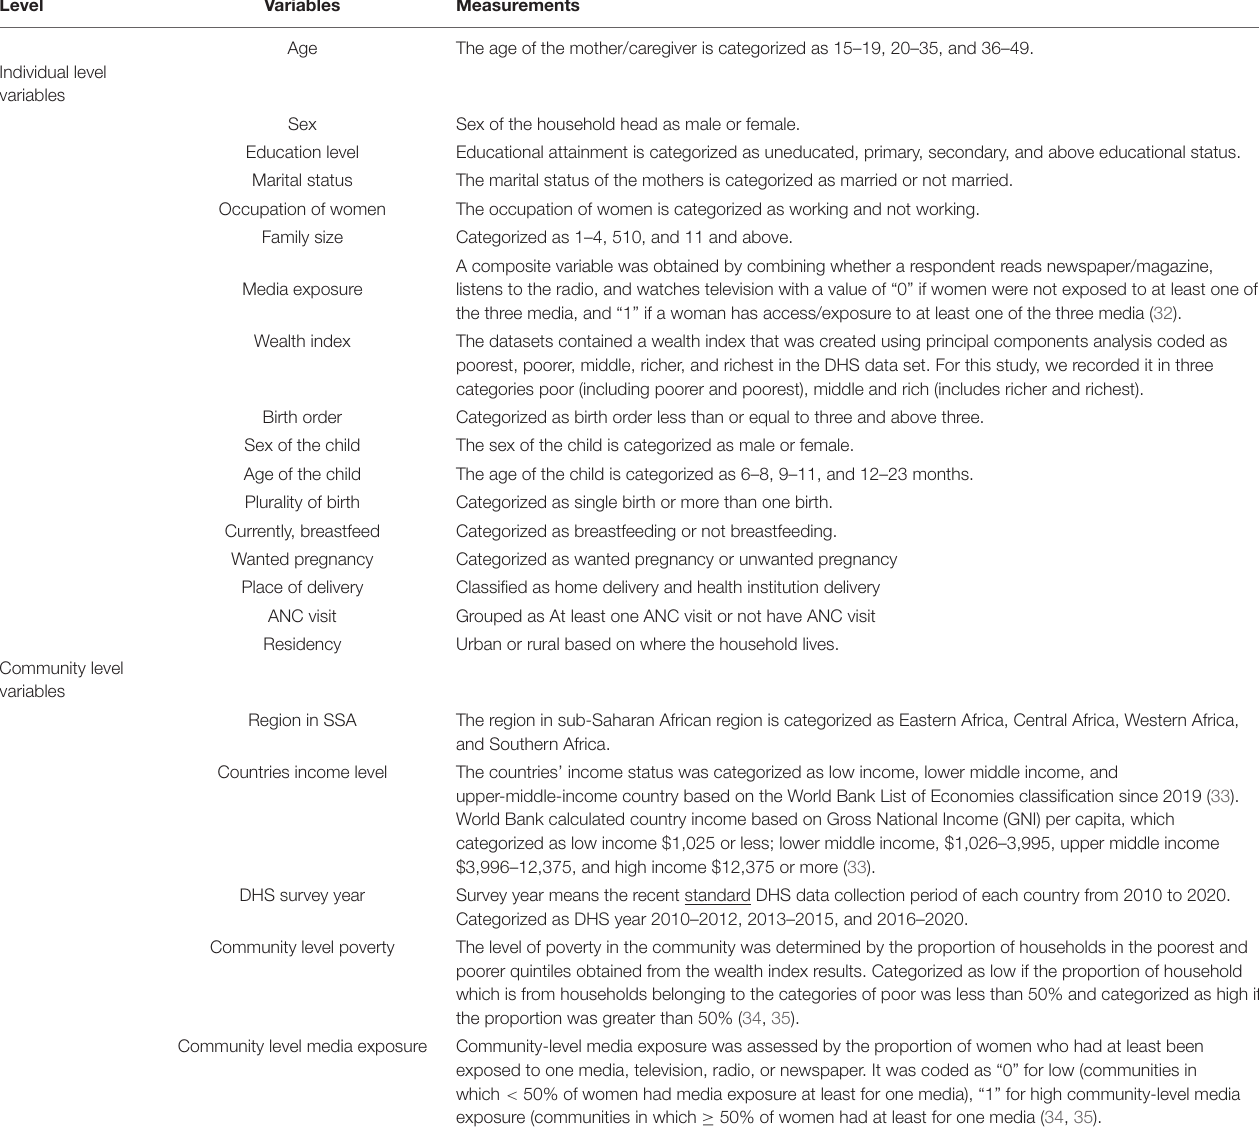
TABLE 3 | Individual and community-level independent variables in the study of inadequate minimum dietary diversity intake and associated factors among children aged 6–23 months in SSA. Level Variables